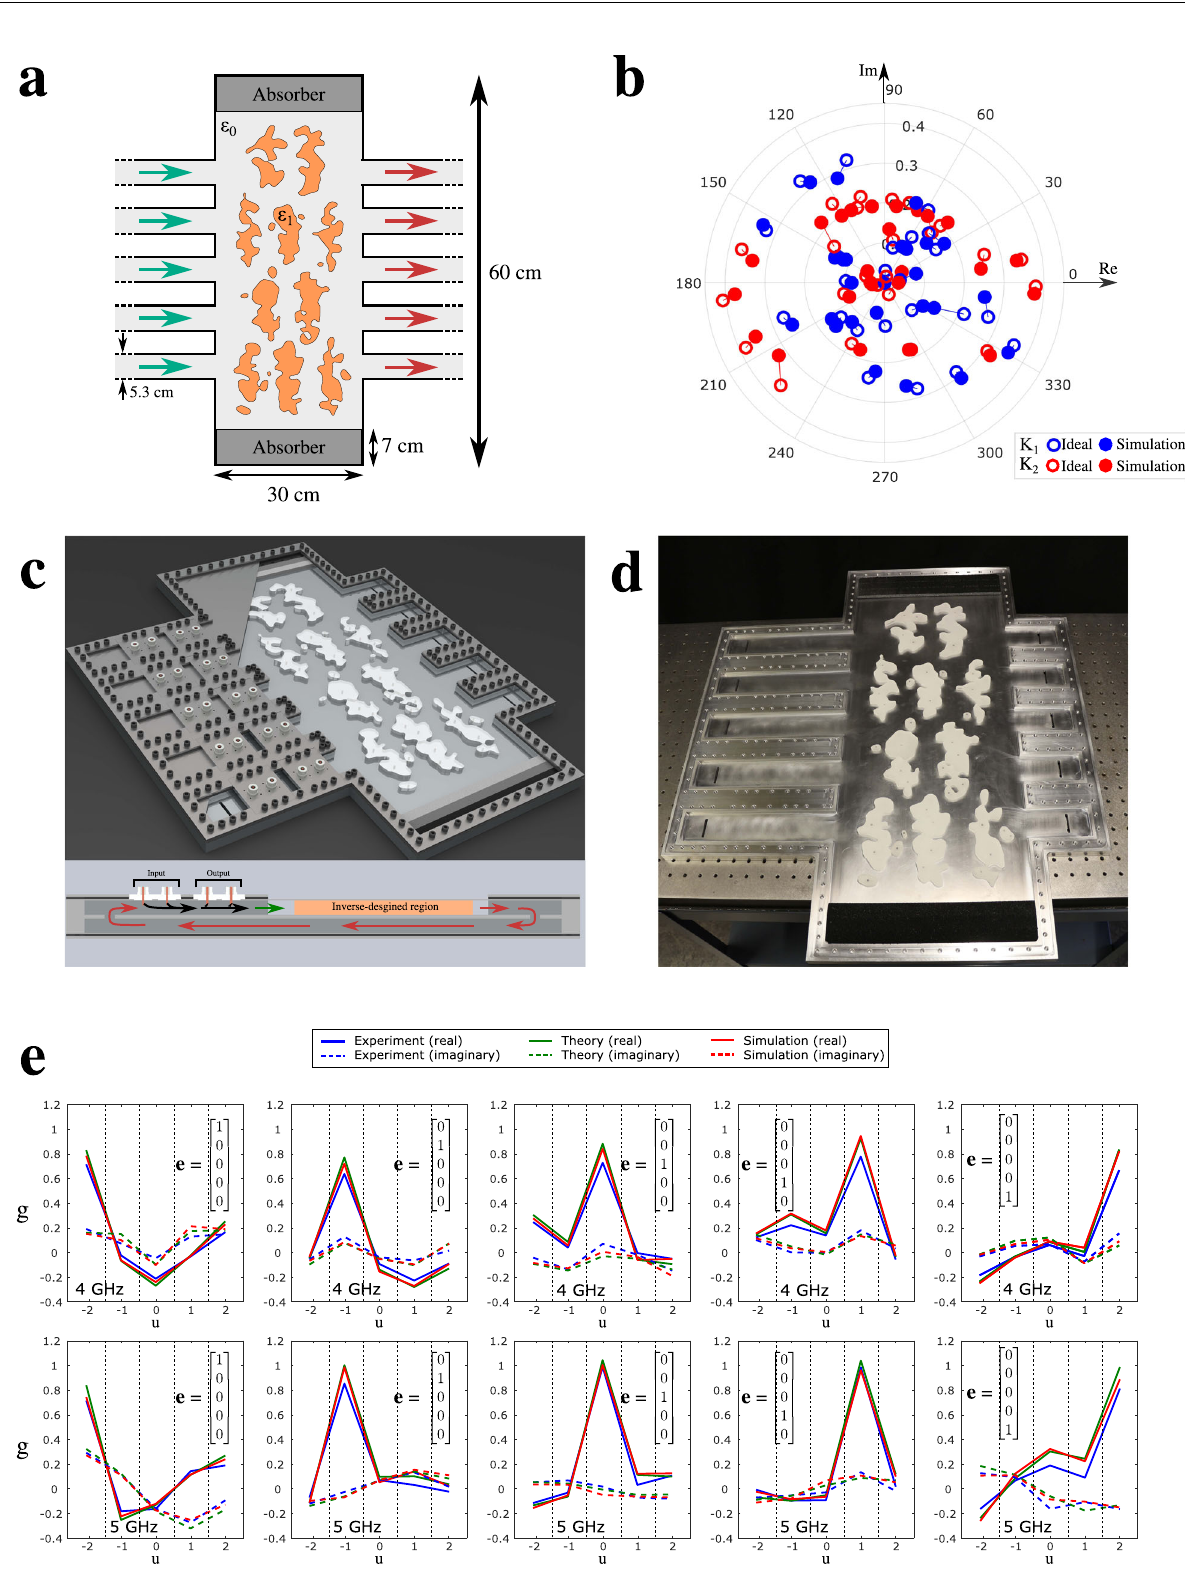
Fig. 2 Experimental demonstration of our device that can solve two integral equations at the same time. a Inverse-designed dielectric distribution that reproduces the two desired mathematical kernels when two waves with two frequencies f 1 and f 2 are used. b Comparison between the simulation results for the transmission scattering matrices of our design at 4 GHz and 5 GHz, and the corresponding ideal required values for such kernels. c Rendering of the device including feedback path through a two-level waveguide system, whose schematic is shown in the bottom part. d Photograph of the constructed device. e Solutions (real and imaginary parts) of the two integral equations for single inputs applied to each of the fi ve input waveguides, obtained theoretically, experimentally and from full-wave